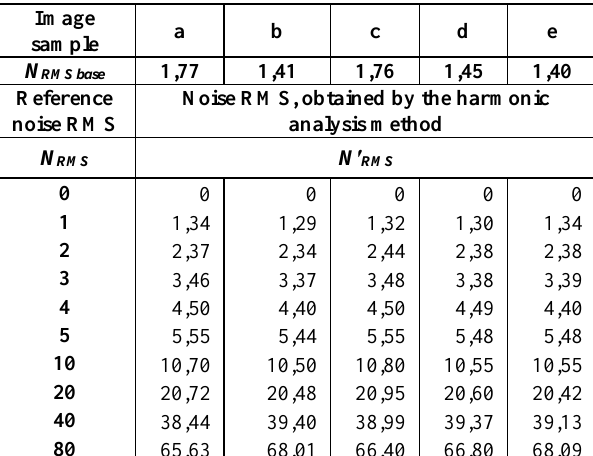
Figure 5. A sample of images, obtained by the Canopus-V spacecraft, with different terrain types for random noise estimation, based on harmonic analysis Based on each of these images, a sample, similar to the test sample described above, was created by adding the random gaussian noise with above RMS values. There were 5 samples in total. The noise RMS was estimated taking into account the native image noise of the original image noise N RMS base . The results of random noise assessing based on harmonic analysis for satellite image samples and their accuracy assessment are shown in Table 2.